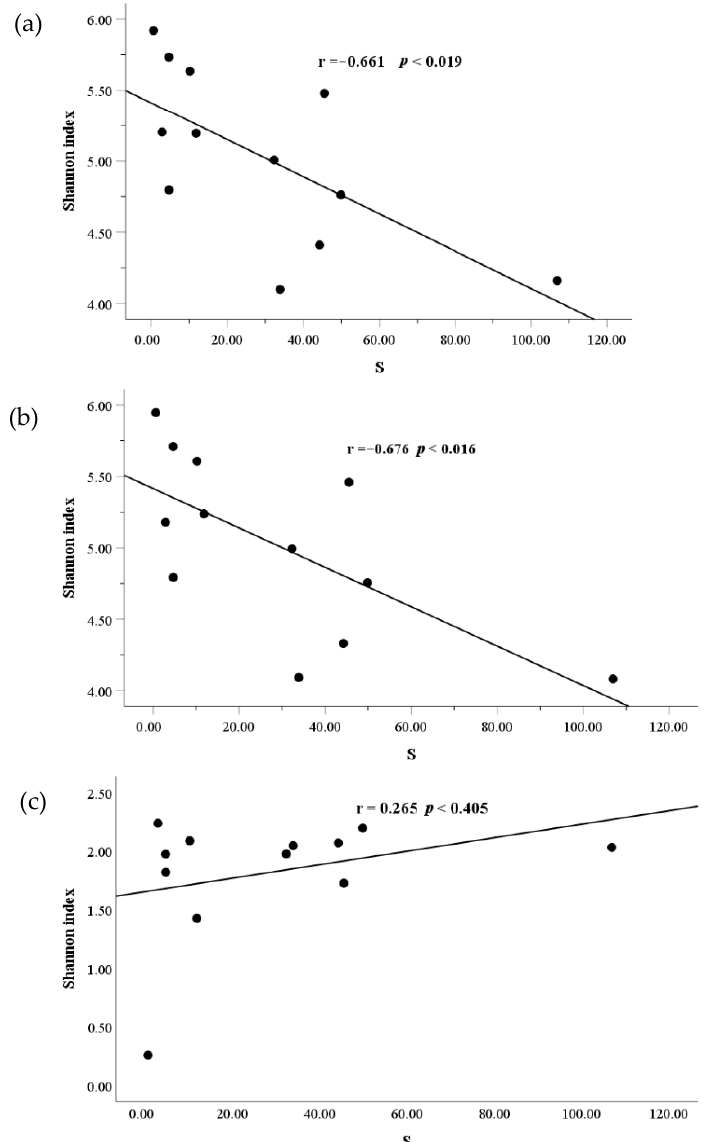
Figure 3. Correlation between Shannon diversity indices and salinity, measured for ( a ) All, ( b ) Bacteria, ( c ) Archaea. (S: Salinity).